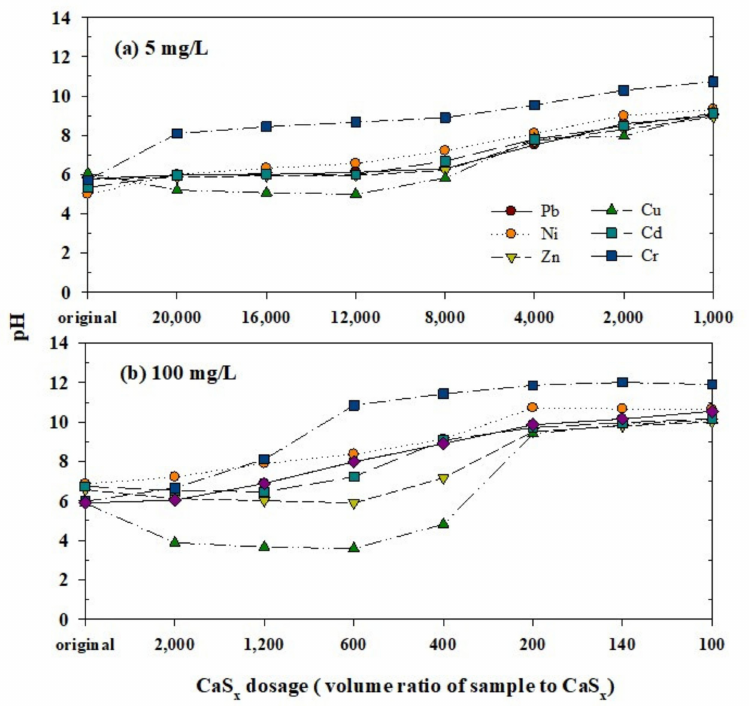
Figure 3. The changes in the pH value of various metal aqueous solutions when different dosages of calcium polysulfide were added, ( a ) for concentration of 5 mg/L, ( b ) for concentration of 100